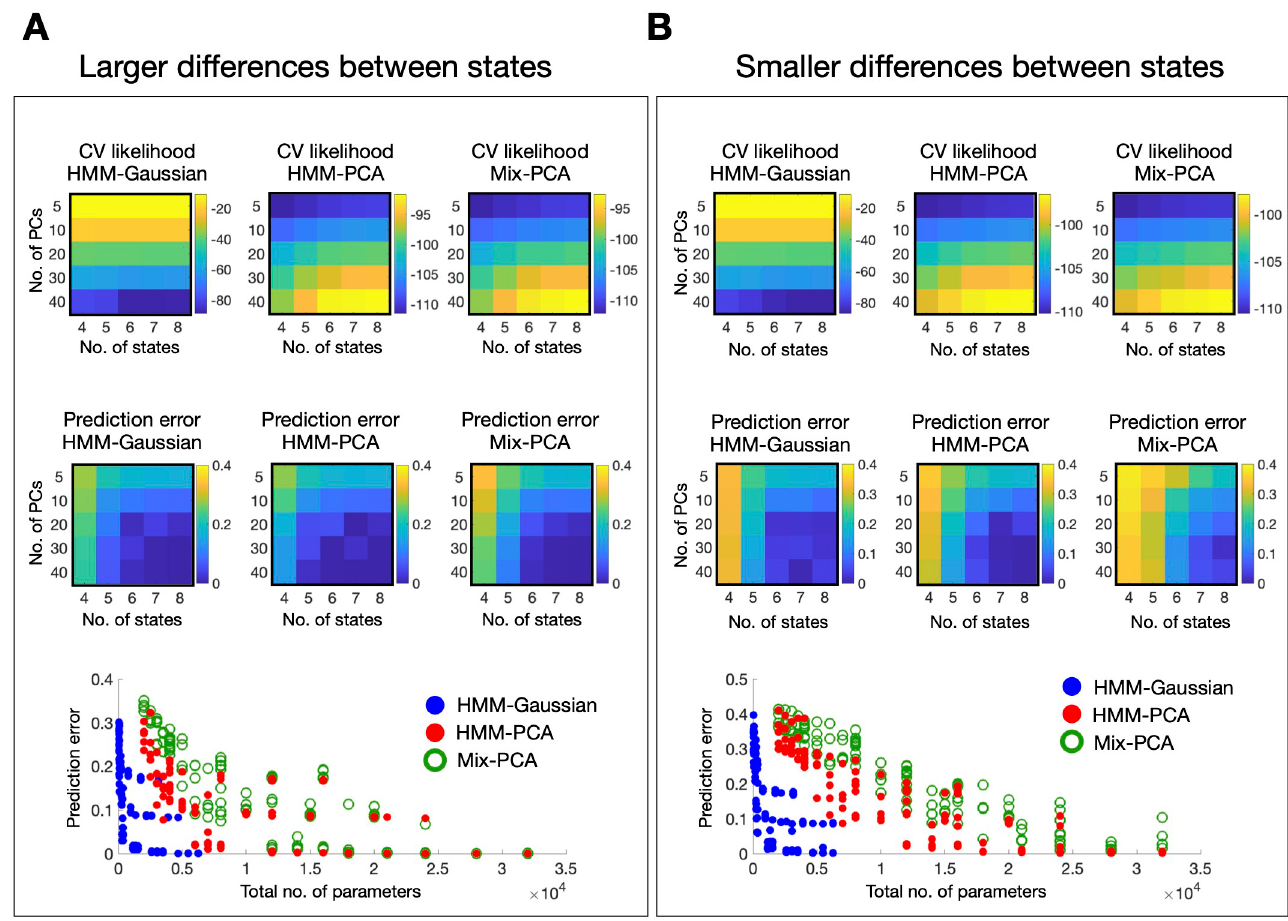
Fig 4. Empirical comparison of HMM-Gaussian, HMM-PCA and Mix-PCA on simulated data. Two different conditions were tested: one with larger (A) and the other with smaller differences between states (B). The models were inferred for a range of states K and principal components p , and the entire process was repeated 10 times (averages are presented); see main text for details. The top panels show the cross-validated likelihood for each combination of parameters and model. The middle panels show the error of each solution (averaged across repetitions of the experiment) in predicting the ground-truth state time courses. The bottom panels show the errors as a function of model complexity for each